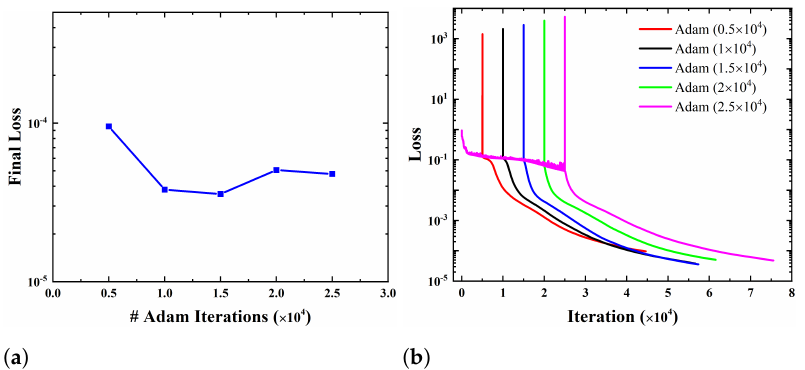
Figure 11. Influence of the number of Adam iterations on convergence of training: ( a ) final loss as a function of the number of Adam iterations; ( b ) convergence histories of training for different numbers of Adam iterations.